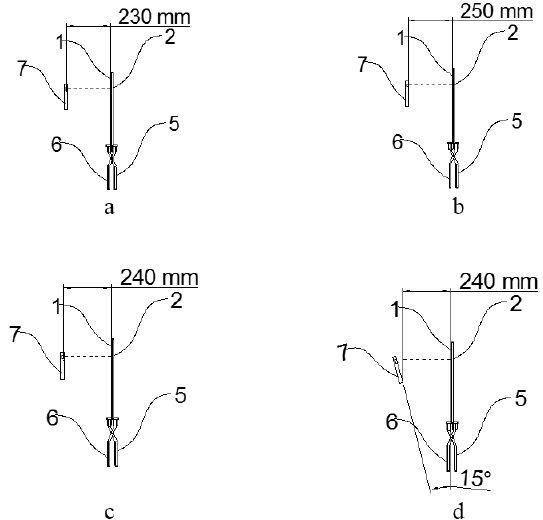
Figure 2. Distance and angle test chart. ( a ) distance from the mobile phone plane to the measuring device plane (230 mm); ( b ) distance from the mobile phone plane to the measuring device plane (250 mm); ( c ) angel between the mobile phone plane and measuring device plane (0 degree); and ( d ) angel between the mobile phone plane and measuring device plane (15 degrees).